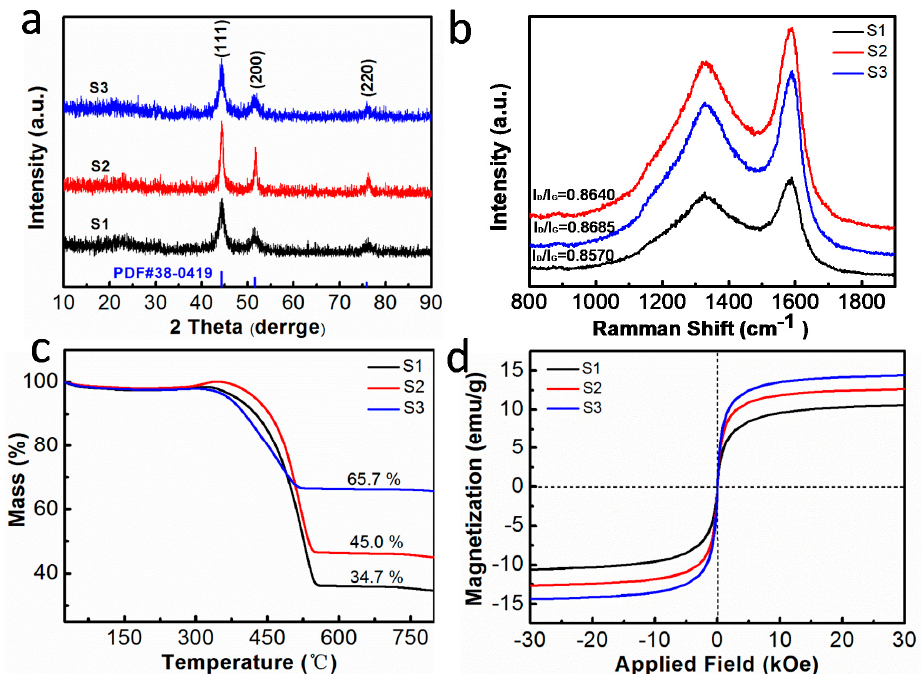
Figure 4. ( a ) XRD patterns of the S1, S2, and S3 samples. ( b ) Raman spectra of the S1, S2, and S3 samples. ( c ) Thermogravimetric (TG) curves of all of the samples under an atmosphere of air. ( d ) Hysteresis loops of the S1, S2, and S3 samples.